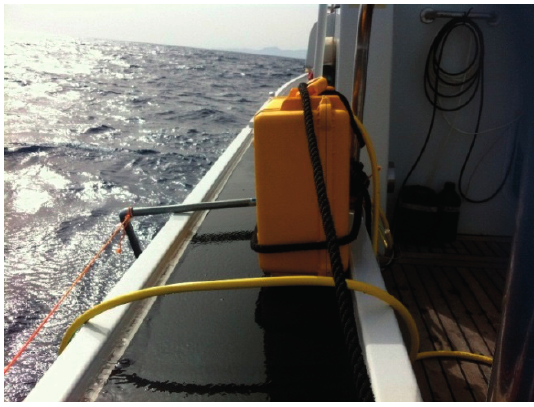
Figure 15. Spectra system installed on board a coastal vessel.